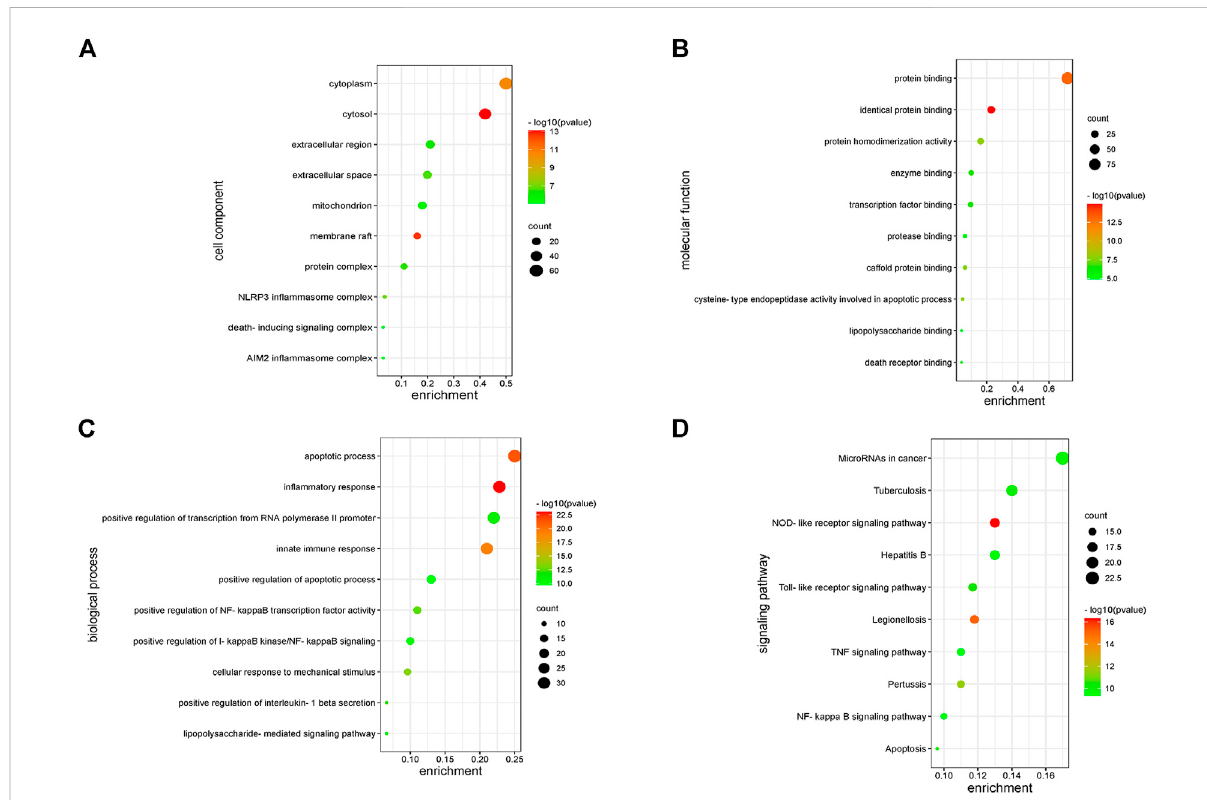
FIGURE 5 Enrichmentanalysisofkeygenes. (A) TheenrichedGOtermsinthecomponent(CC). (B) TheenrichedGOtermsinthemolecularfunction(MF).